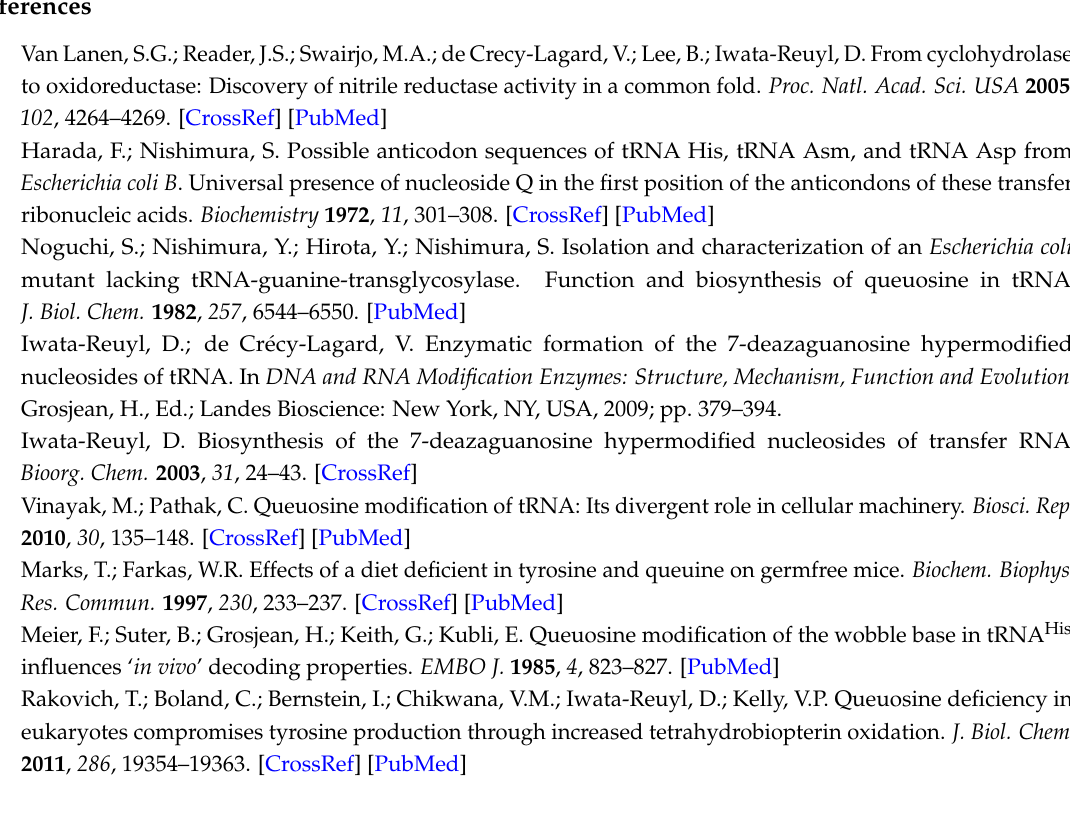
Figure S1: 3D homology model of unimodular QueF, which lacks the disulfide forming Cys99, but contains Cys53 in proximity to the catalytic Cys55 in the active site loop. The model was generated using the Aquifex aeolicus QueF sequence and the Phyer2 server (http://www.sbg.bio.ic.ac.uk/phyre2/html/page.cgi?id=index). Table S1: Classification of 164 bacterial pathogens based on the subfamily that their QueF proteins belong to and the presence/absence of the disulfide forming Cys99 (and the homologous Cys236 in bimodular QueF) in the protein